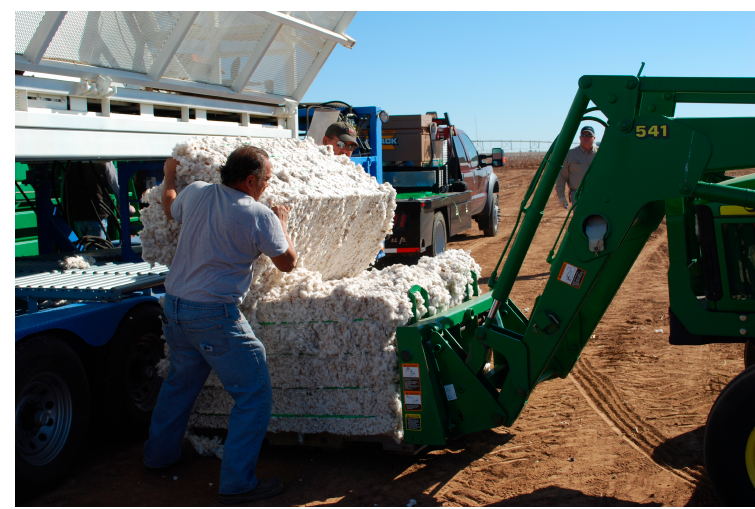
Figure 5. Micro-module exiting the weigh cart/micro-module builder.